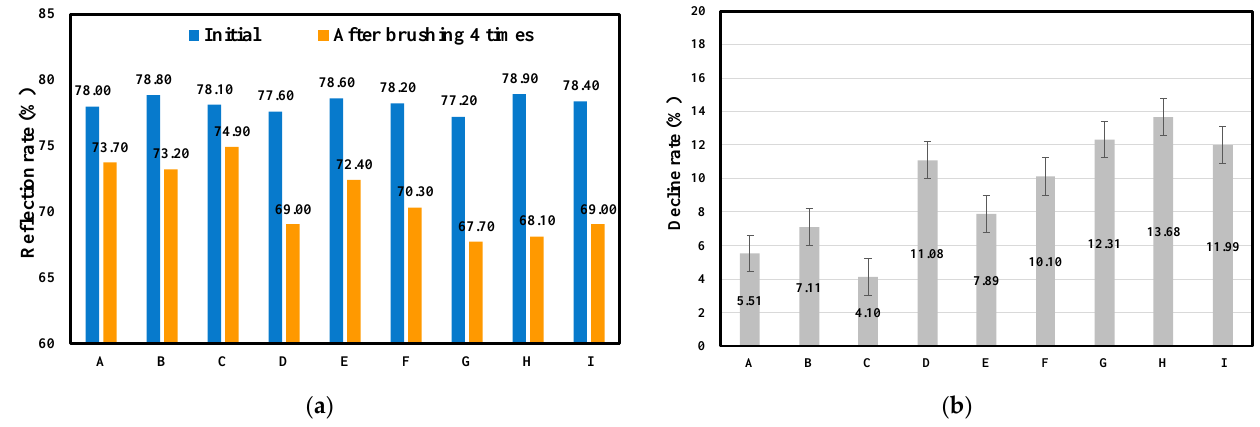
Figure 3. Design 1: ( a ) the change in the reflection rate and ( b ) the decline rate (after brushing 4 times).